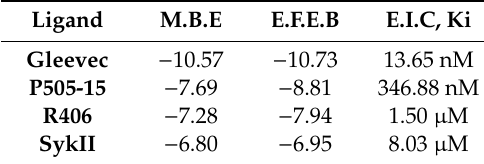
Table 5. Data showing the binding energy and inhibition constant (Ki) values obtained from the docking analysis of Syk inhibitors with 4FL2. Abbreviations: mean binding energy, M.B.E; estimated free energy of binding, E.F.E.B; estimated inhibition constant, E.I.C.